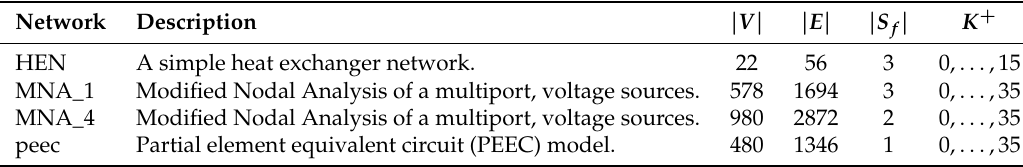
Table 1. The main parameters of the networks studied in the examples. | V | denotes the number of state variables, | E | stands for the number of the connections between the state variables, | S f | represents the number of fixed sensor nodes, and K + denotes the number of additional nodes to be